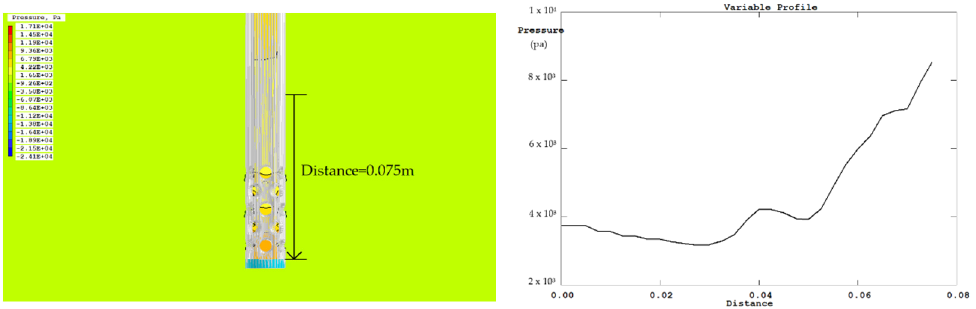
Figure 6. Variation of the fuel pressure inside the injector with distance.